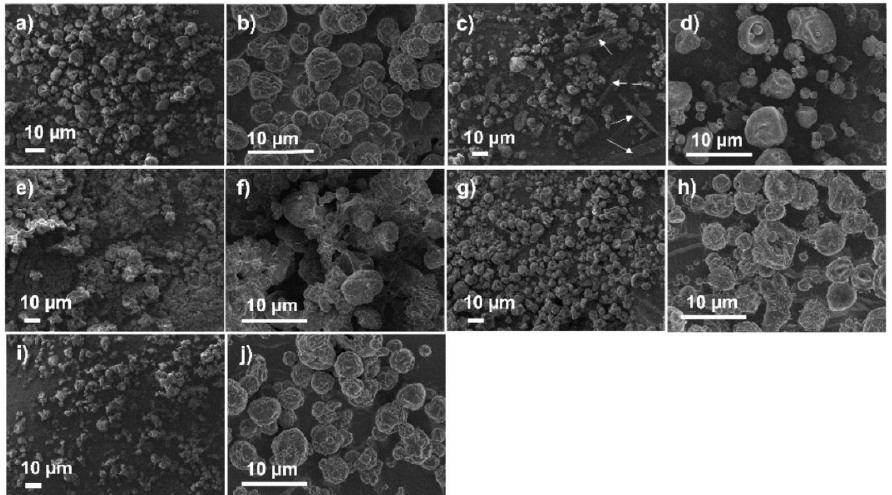
Figure 5. FEG-SEM images of 5-ASA-loaded RS/P samples prepared by spray drying employing different strategies to improve drug solubility before the drying process: RS/P5ASA0.5% with 500× ( a ) and 2000× magnification ( b ), RS/P5ASA1.0% with 500× ( c ) and 2000× magnification ( d ), RS/P5ASA-HCl with 500× ( e ) and 2000× magnification ( f ), RS/P5ASA-NaOH with 500× ( g ) and 2000× magnification ( h ), and RS/P5ASA-polysorbate with 500× ( i ) and 2000× magnification ( j ). White arrows indicate the presence of crystals as free drug (unencapsulated).